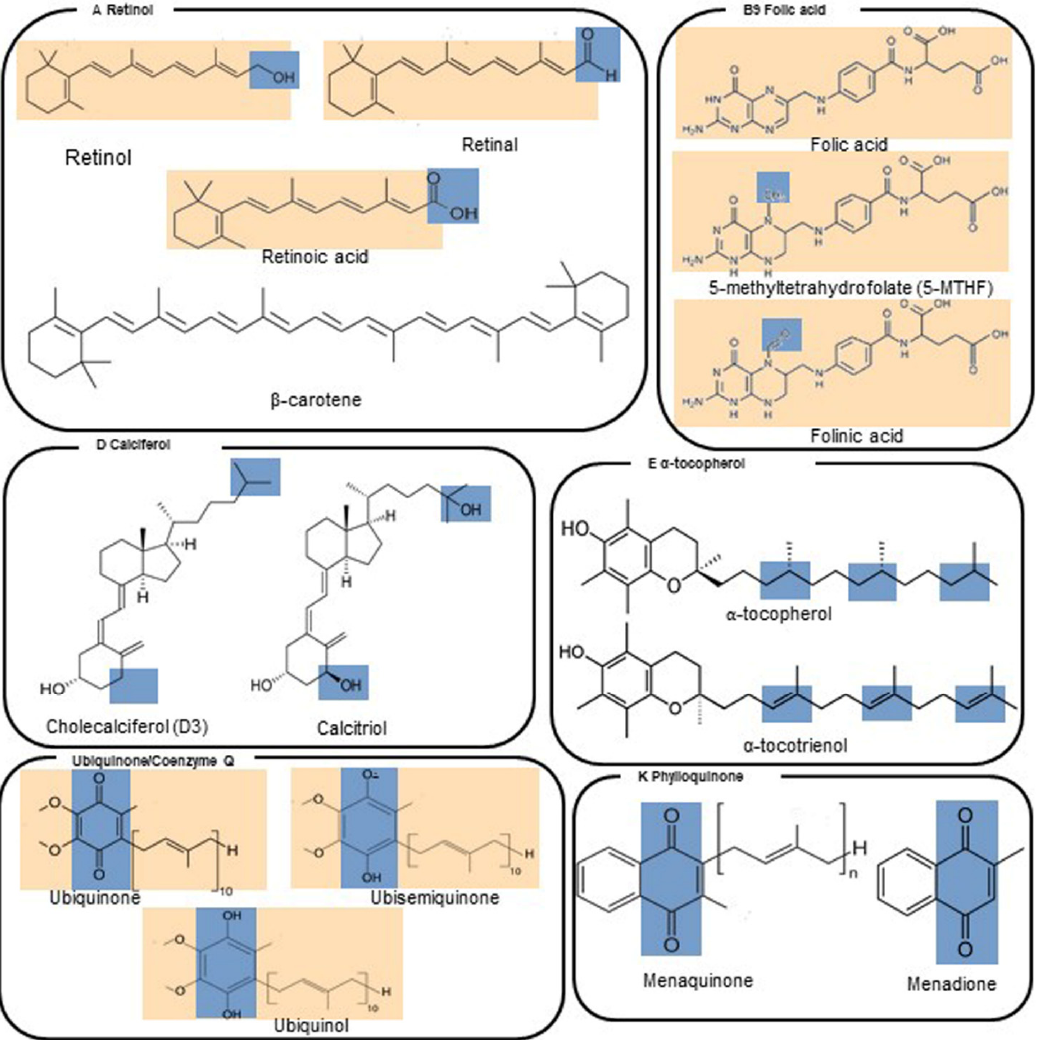
Figure 1. 2D structures of vitamins and derived enzyme cofactors. Orange squares indicate the vitamin portion of each reported molecule. Blue squares indicate the reactive centers involved in electron transfer and/or redox